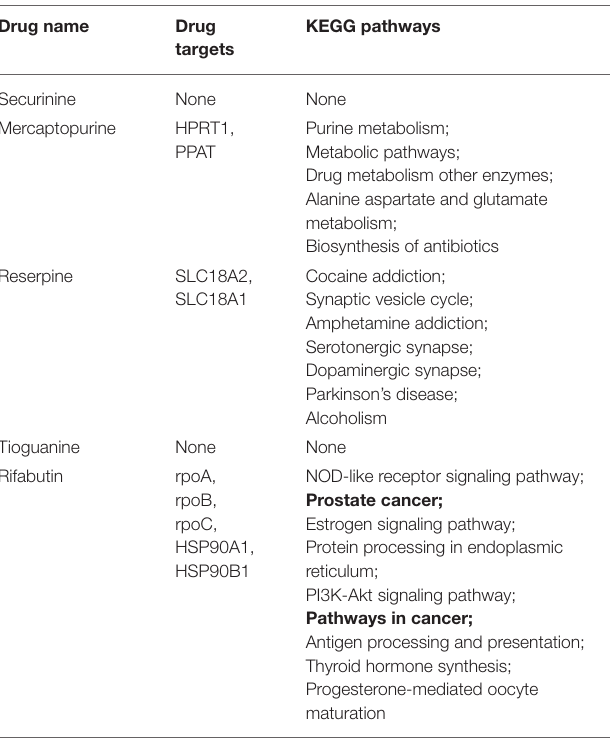
TABLE 5 | Pathway enrichment analysis result of five selected drugs.